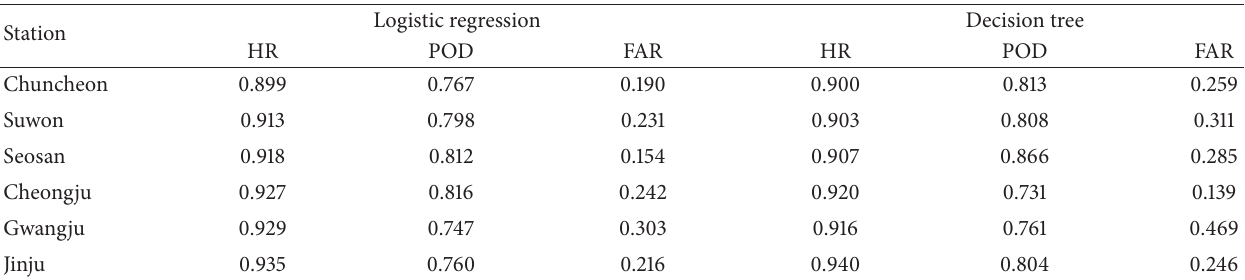
Table 4: Hit Rate (HR), Probability of Detection (POD), and False Alarm Rate (FAR) by the logistic regression and decision tree models. Logistic regression Decision Station